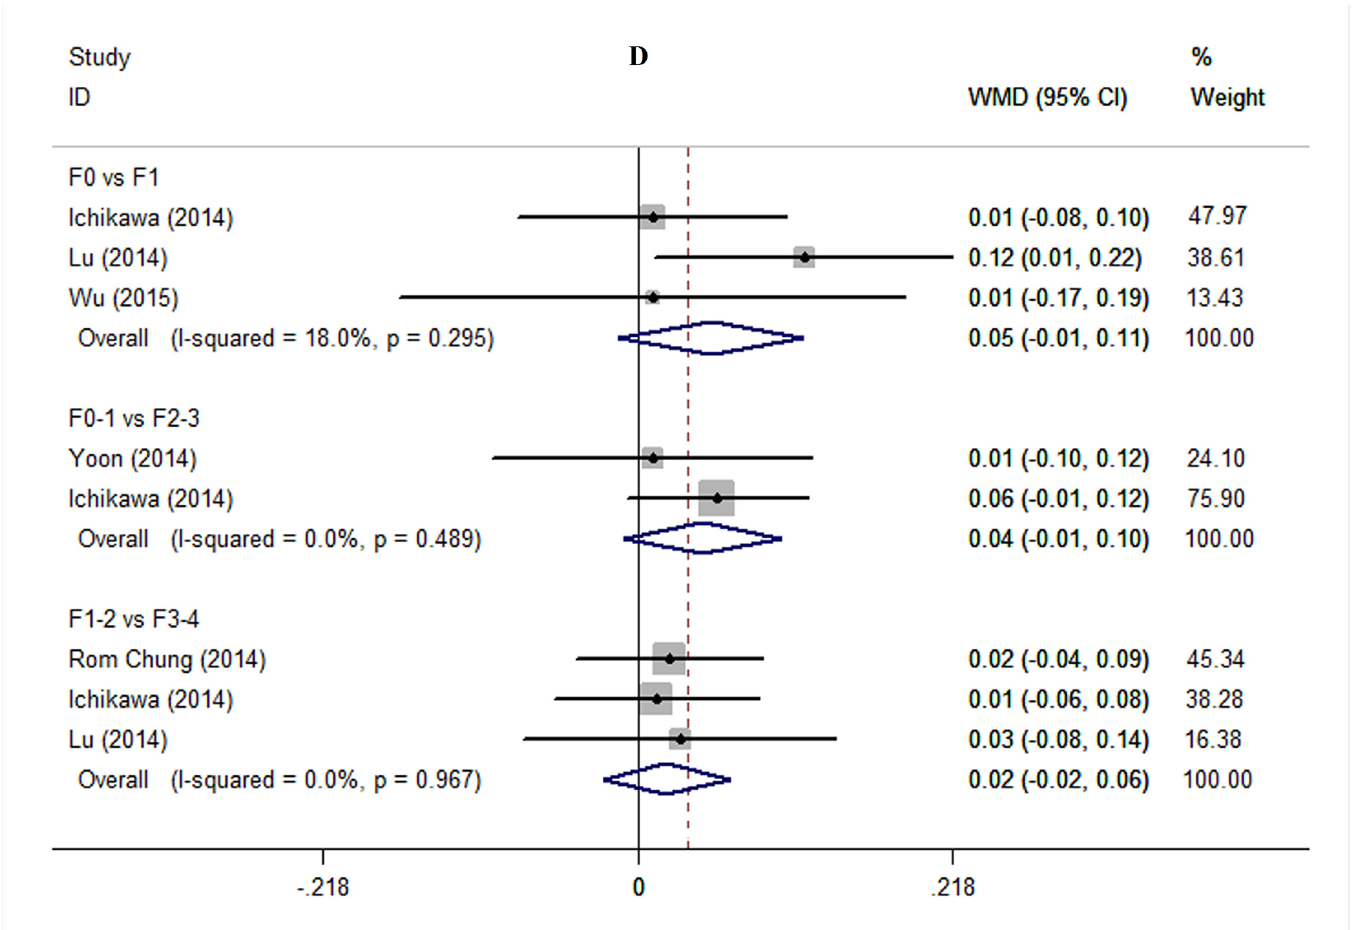
Fig 5. Comparing stage F0 with F1, F0-1 with F2-3, and F1-2 with F3-4 using D. We used influence analysis to drop a study exerted excessive influence on the overall estimate and therefore to decrease the heterogeneity. Abbreviations: WMD = weighted mean difference; CI = confidence